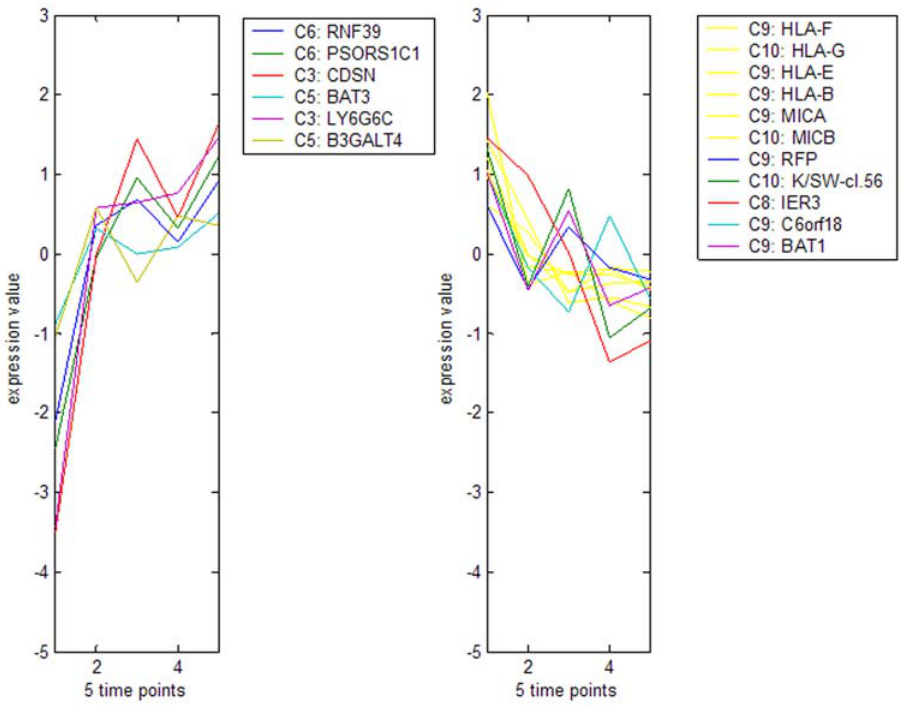
Figure 5. Expression of MHC genes during keratinocyte differentiation. The figure shows abundance levels of those transcripts from the extended MHC which vary significantly during keratinocyte differentiation. Gene transcripts of increasing abundance are shown in the left panel, and transcripts of decreasing abundance on the right. The expression cluster containing each transcript is listed before each gene